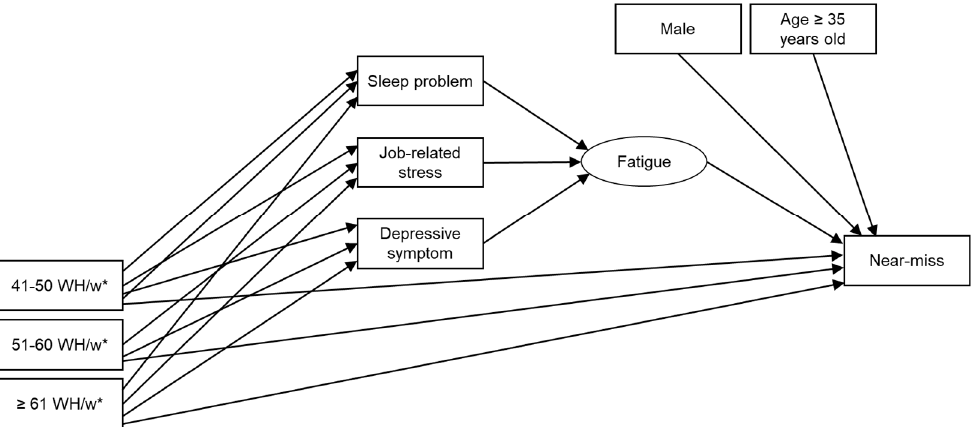
Figure 1. Structural equation model for the relationship between near-misses and working hours. WH, working hours; w, week. * Reference category is 35–40 WH/w. “41–50 WH/w”, “51–60 WH/w”, “ ≥ 61 WH/w”, “Male”, and “Age ≥ 35 years old” are dummy variables, coded 1 if applicable and 0 otherwise; the circle represents a latent